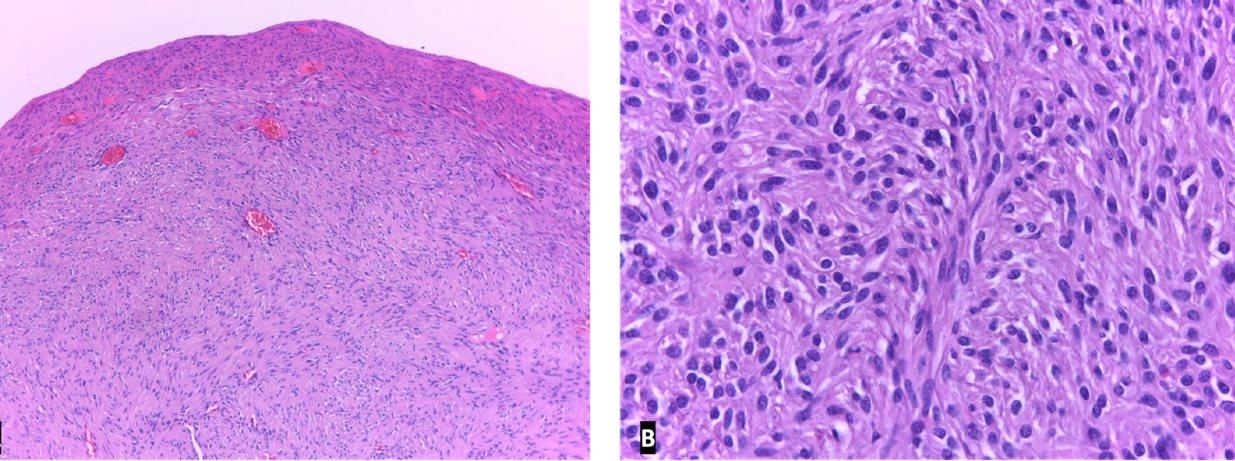
Figure 11. GIST of jejunum. Interlacing fascicles of monomorphus spindled cells, in Hematoxylin and eosin stain, ×40 ( A ) and ×400 ( B ).